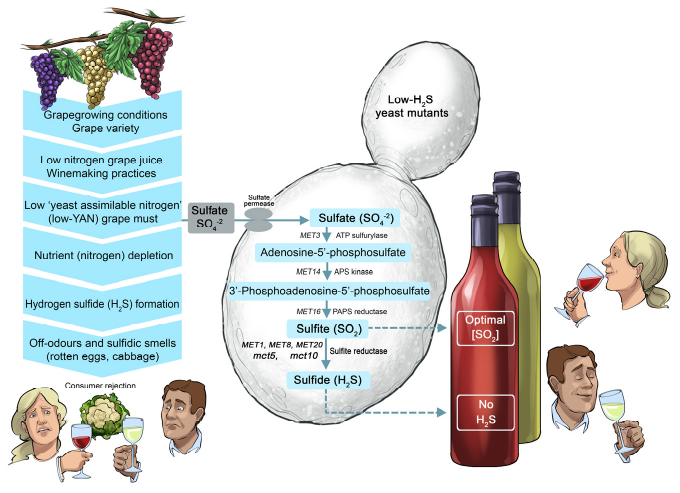
Figure 15. The construction of wine strains of Saccharomyces cerevisiae that produce low or no concentrations of hydrogen sulfide which can spoil the aroma and quality of wine. Low-H 2 S mutants are now commercially available to winemakers.